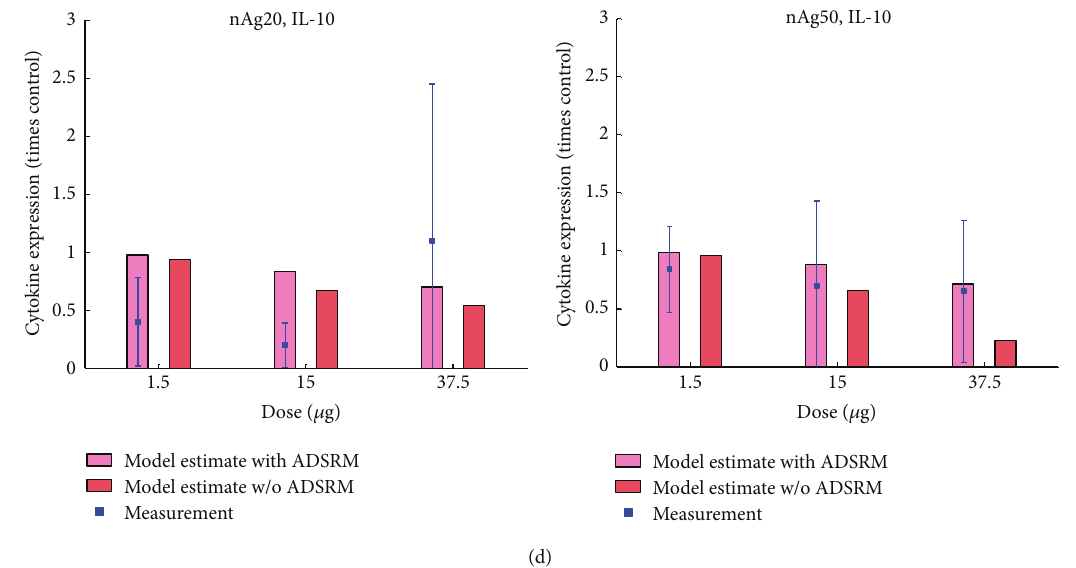
Figure 9: Comparison of model predictions with and without using ADSRM for cellular dosimetry estimation against measured values of cytokine levels in culture medium with different doses of 20nm and 50 nm nAg in vitro with 4-hour